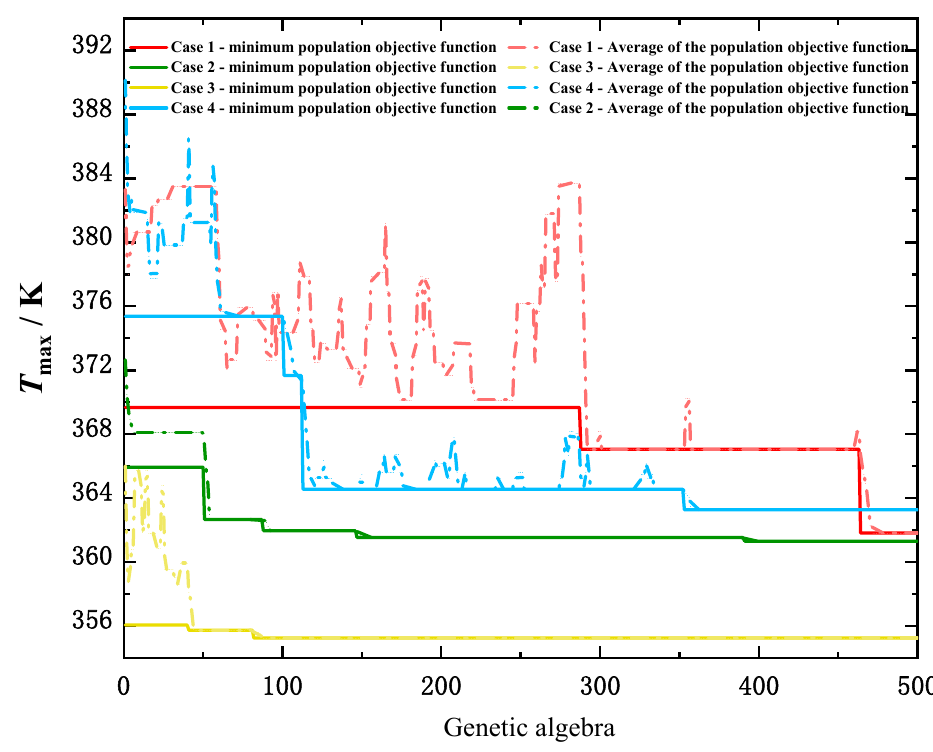
Figure 9. Intergenerational optimization trajectory diagram.